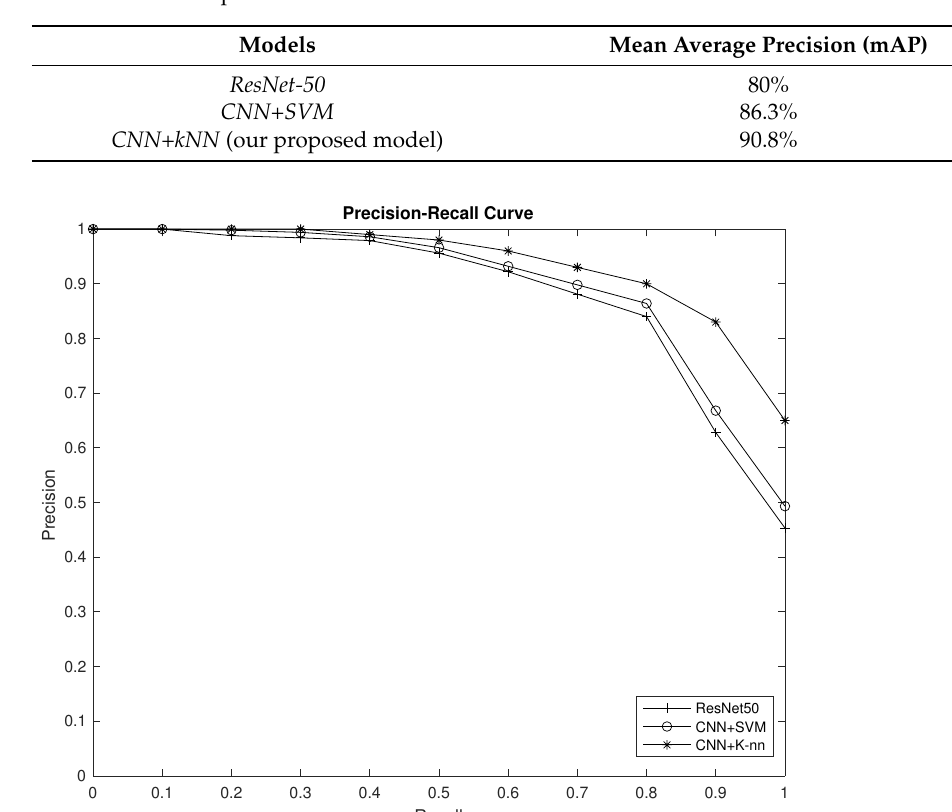
Table 2. mAP Comparison Models.